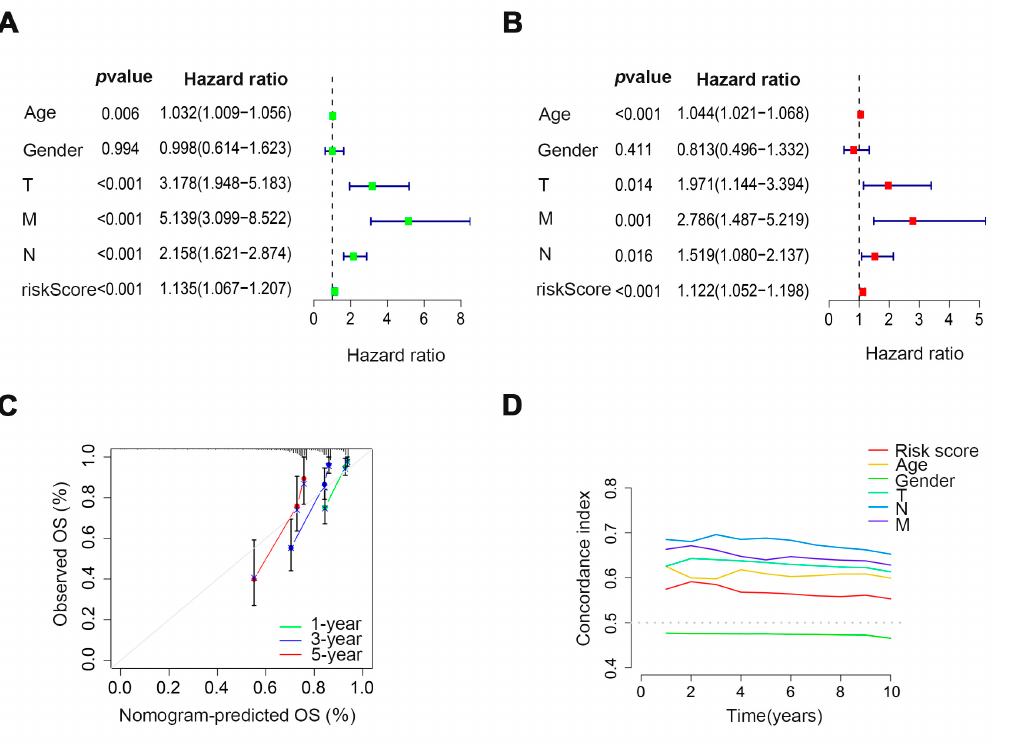
Figure 4. The prognostic ability of four cuproptosisrelated glycosyltransferases in COAD patients was verified. Univariate ( A ) and multivariate ( B ) COX regression analysis showed that risk score could be utilized as a prognostic factor. ( C ) The calibration curve predicted the patient’s OS at 1, 3, and 5 years in all samples. ( D ) C-index curves were used to assess the discrimination between the risk scores and other clinical features at different time points. PCA shows the sample distributions of all genes ( E ), cuproptosis-related genes ( F ), glycosyltransferases ( G ), and four cuproptosis-related glycosyltransferases ( H ) .